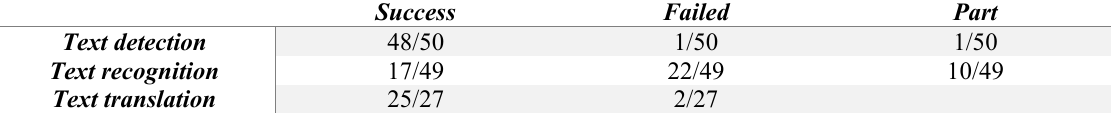
Fig. 8. Random dataset testing results Table 5. Number of images detected, recognized and translated in random dataset.